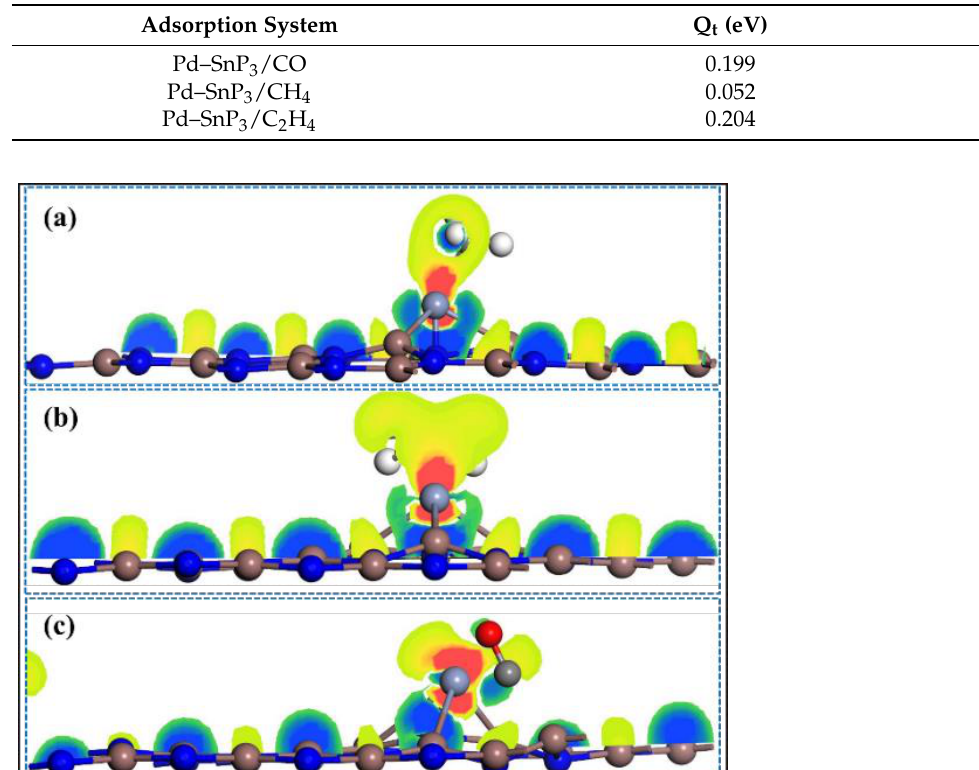
Table 1. The charge-transfer capacity of CH 4 , CO, and C 2 H 4 on the Cr–InN monolayer.